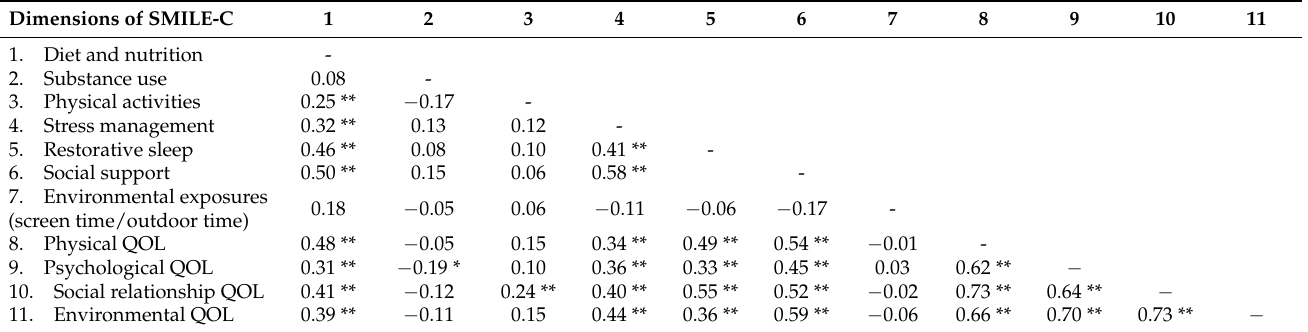
Table 4. Examining convergent validity by dimension of SMILE-C and WHOQOL-BREF. Dimensions of SMILE-C